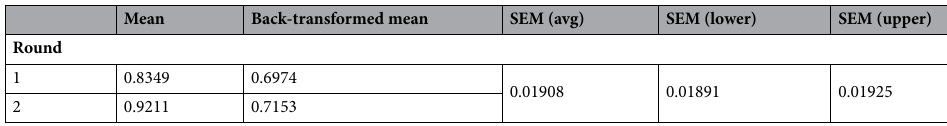
Table 1. Consensus and group stability of welfare indicators: generalized linear mixed model (GLMM) 1 [respondent, round, indicator (fixed effects); respondent (random